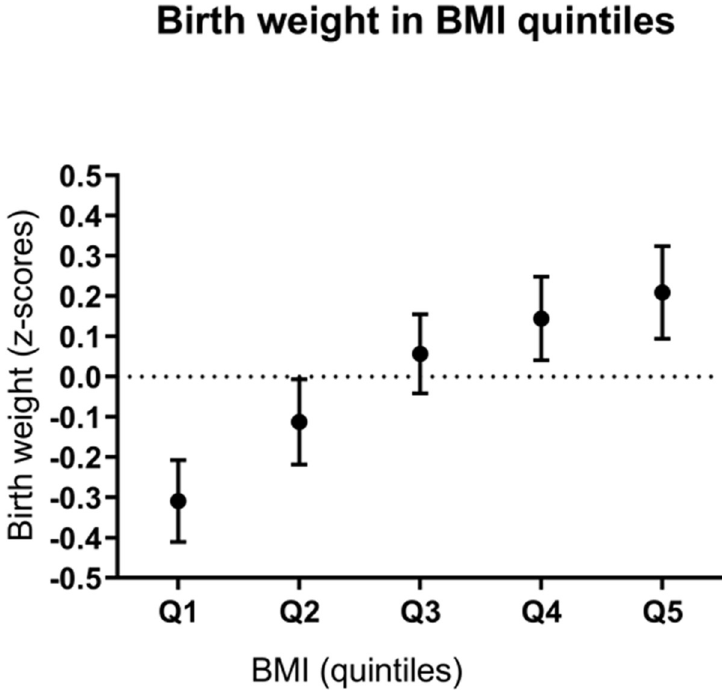
Fig 3. Mean birth weight (z-scores; adjusted for gestational age) in BMI quintiles (95% confidence intervals).